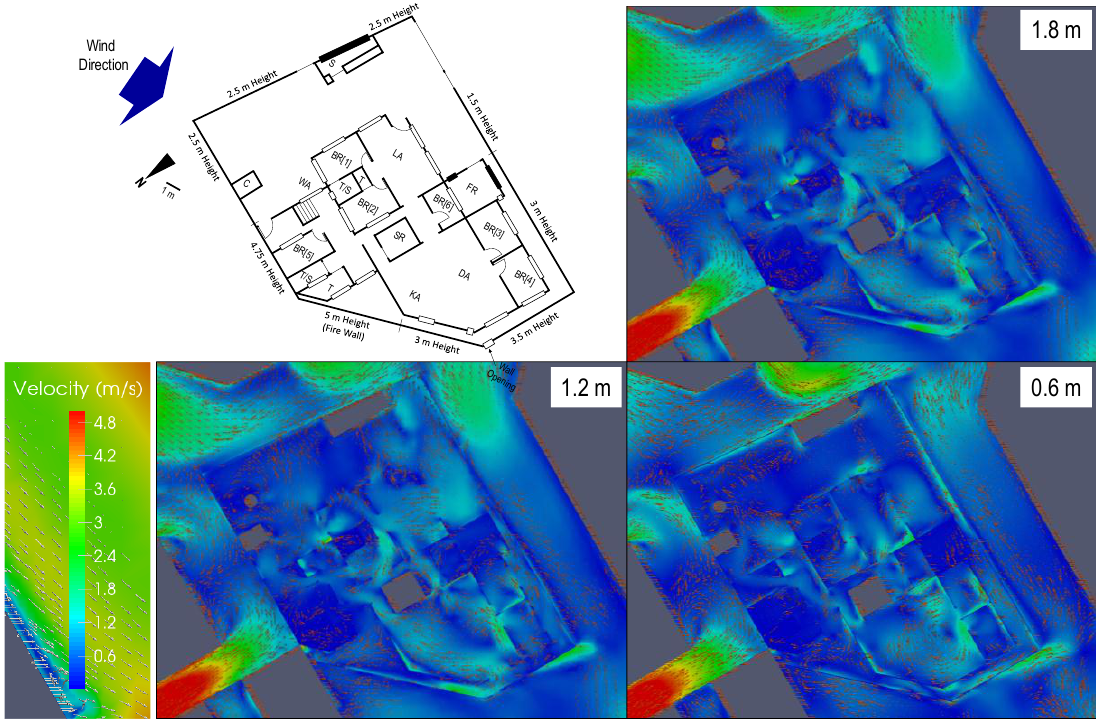
Figure 11 . Case 6—High lot perimeter wall and firewall with left lot perimeter wall opened (all windows and doors opened) wind velocity around and inside the detached family house for three vertical heights (1.8 m, 1.2 m, and 0.6 m above the floor).